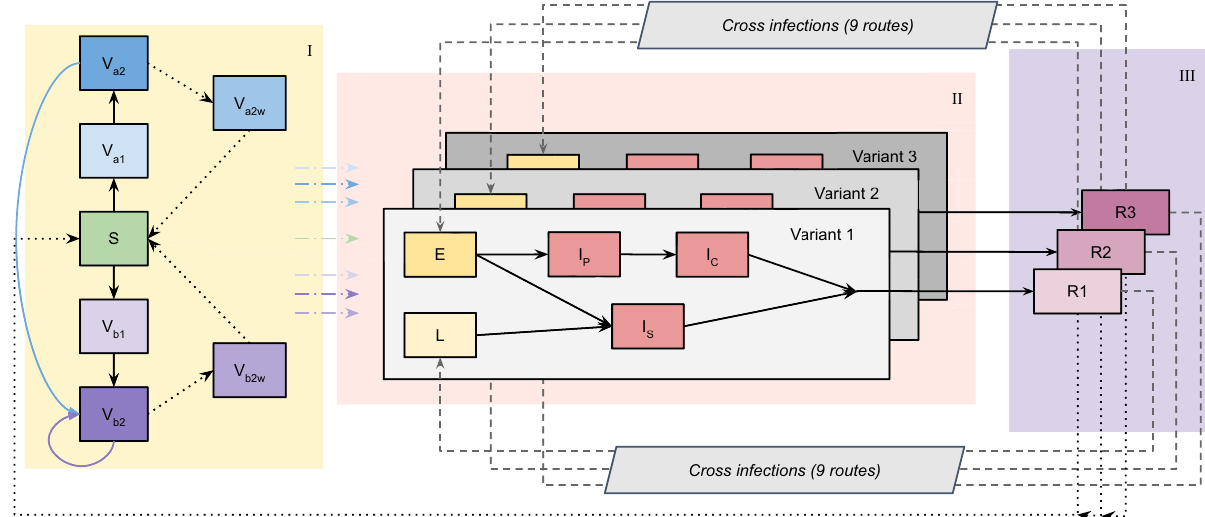
Fig. 1 | Compartmental model diagram. A three-variant deterministic dynamic susceptible-exposed-infected-recovered (SEIR) compartmental model with clinical and sub-clinical infectious pathways and with vaccination describes SARS-CoV-2 transmission in England. We model seven NHS England regions 66 separately, with eachdividedinto16 fi ve-yearagegroups:0 – 4yearsupto70 – 74years,and75years and older. The model incorporates COVID-19 vaccination with two vaccine